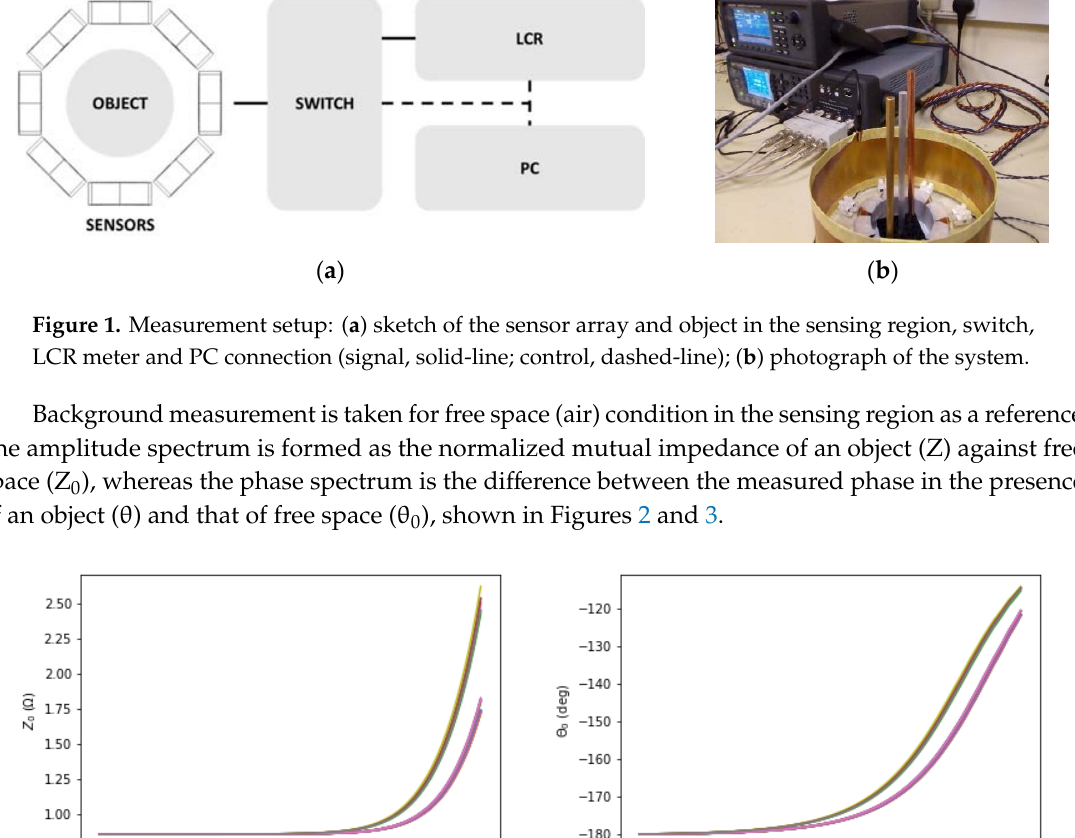
Figure 1. Measurement setup: ( a ) sketch of the sensor array and object in the sensing region, switch, LCR meter and PC connection (signal, solid-line; control, dashed-line); ( b ) photograph of the system.